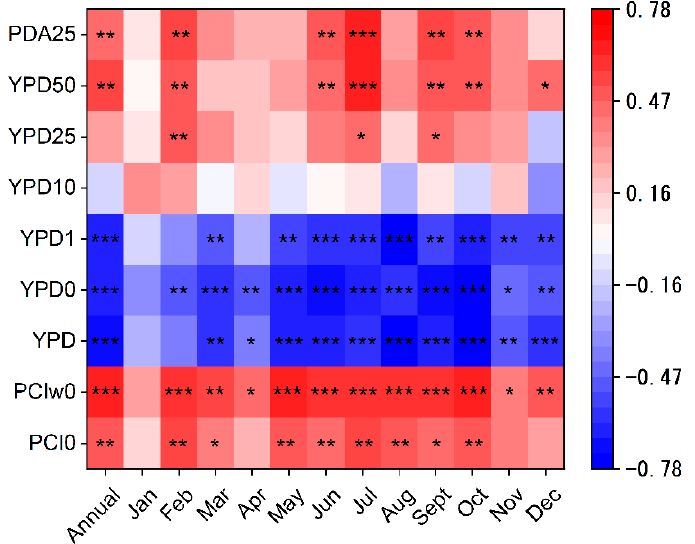
Figure 6. Relationship between the NDVI and precipitation over the Daning River basin. PCI0 is the precipitation concentration index of SP (0.1–0.9 mm); PCIw0 is the precipitation concentration index of SP (0.1–0.9 mm) for the wet season, YPD is the annual number of rainy days, YPD0 is the annual number of rainy days of SP (0.1–0.9 mm), YPD1 is the annual number of rainy days of LP (1–9.9 mm), YPD10 is the annual number of rainy days of MP (10–24.9 mm), YPD25 is the annual number of rainy days of HP (25–49.9 mm), YPD50 is the annual number of rainy days of EP ( ≥ 50 mm), and PDA25 is the annual number of rainy days of PA25 ( ≥ 25 mm). * Significance at 10% level; ** significance at 5% level; *** significance at 1% level.